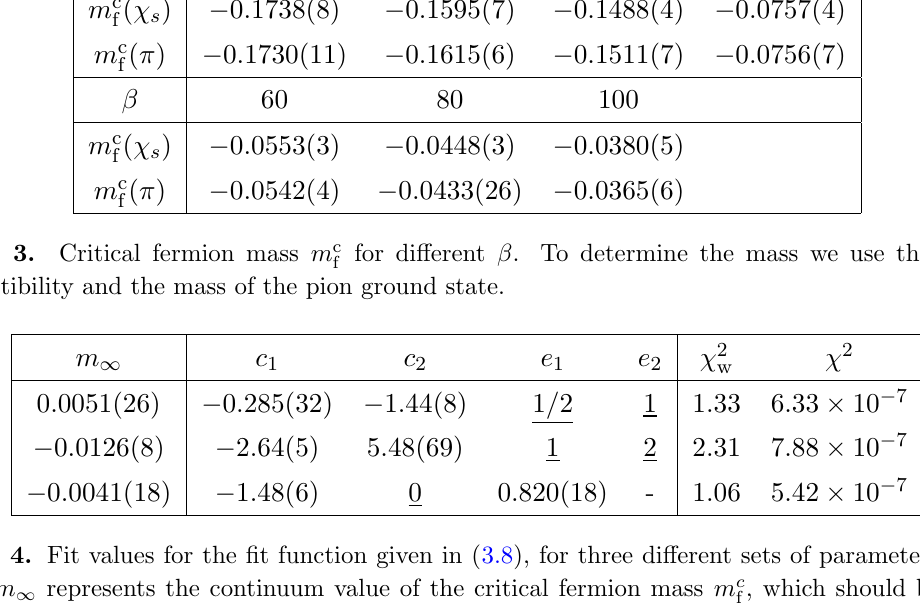
, which should be zero. f